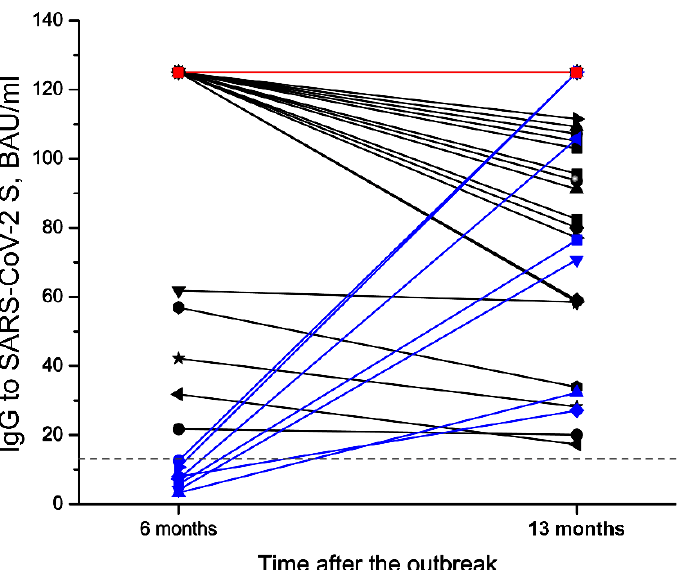
Figure 3. The levels of SARS-CoV-2-specific IgG in a group of previously infected non-vaccinated participants (n = 39) including 1 reinfection case (red line) in the second and the third serological testing. Between the 6th and 13th month after SARS-CoV-2 infection, a decline of virus-specific IgG levels was observed in 17 individuals (black lines); the IgG levels remained stable in 14 individuals (overlapping red lines) and increased in 7 individuals (blue lines).